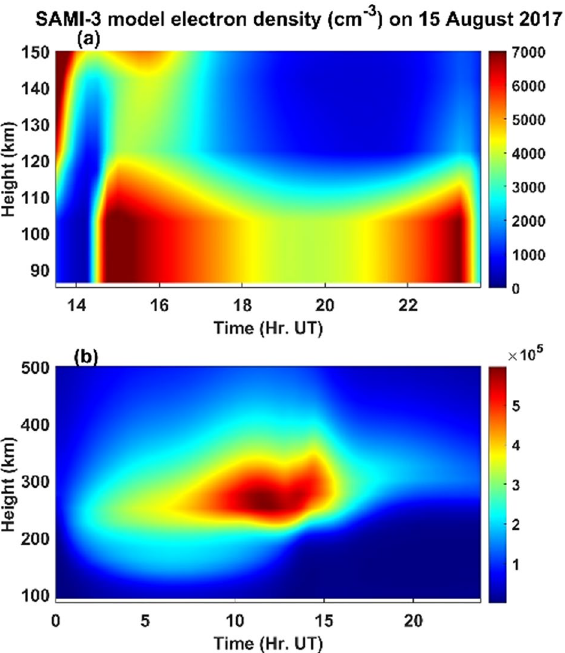
Figure 10. Presents the results of SAMI3 ionosphere model ( a ) time evolution (13:30 – 24:00 UT) of electron density in the heights of 85–150 km for the Srinagar location (75° E; 34° N geographic) on 15 August 2017 ( b ) same as a except for the heights of 85–500 km and time of 00:00–24:00 UT. 1.3 and 8.3 km are the height resolutions for ( a ) and ( b )